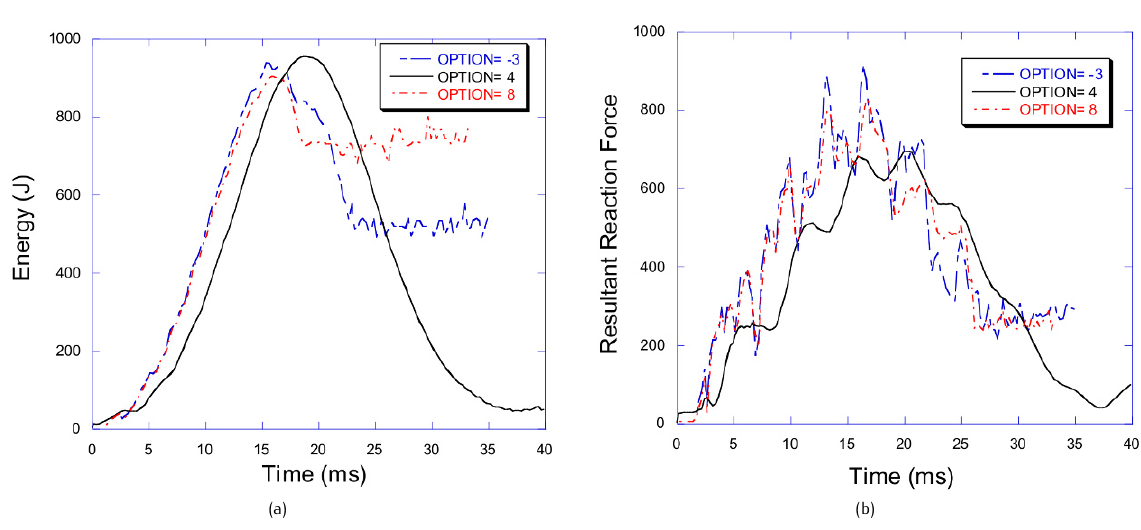
Figure 13. Comparison of (a) absorbed energy and (b) contact force of composite plate using different number of sublaminates with SFS = SFM = 0.1.